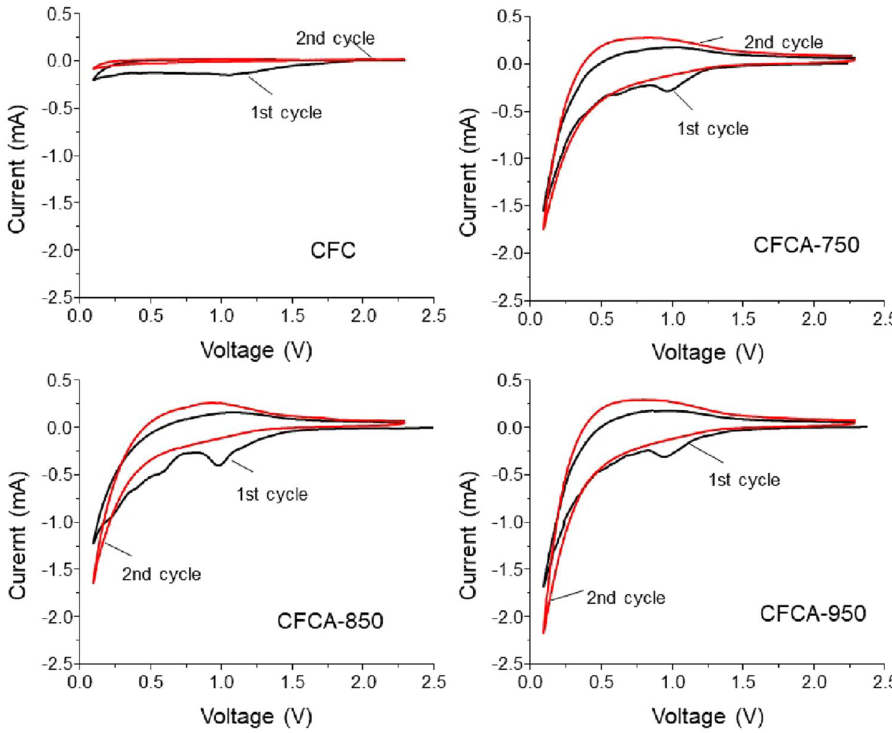
Fig. 6 CV curves of CFC and